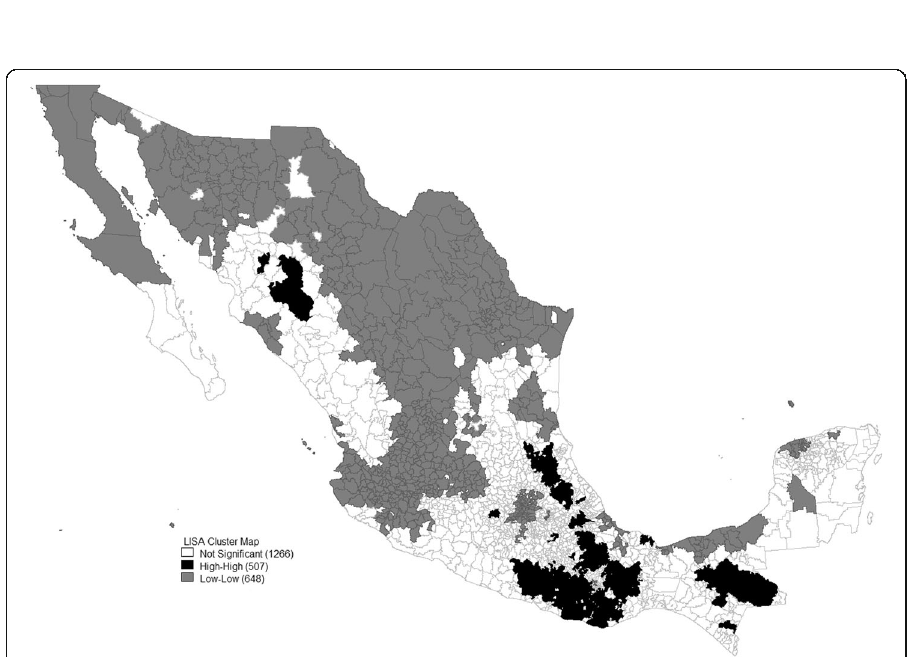
Fig. 6 LISA cluster map for all the municipalities. México 2015. Note: high-high, high social lag is surrounded by municipalities high social lag in black, and low-low, municipalities with low social lag surrounded by municipalities with low social lag in